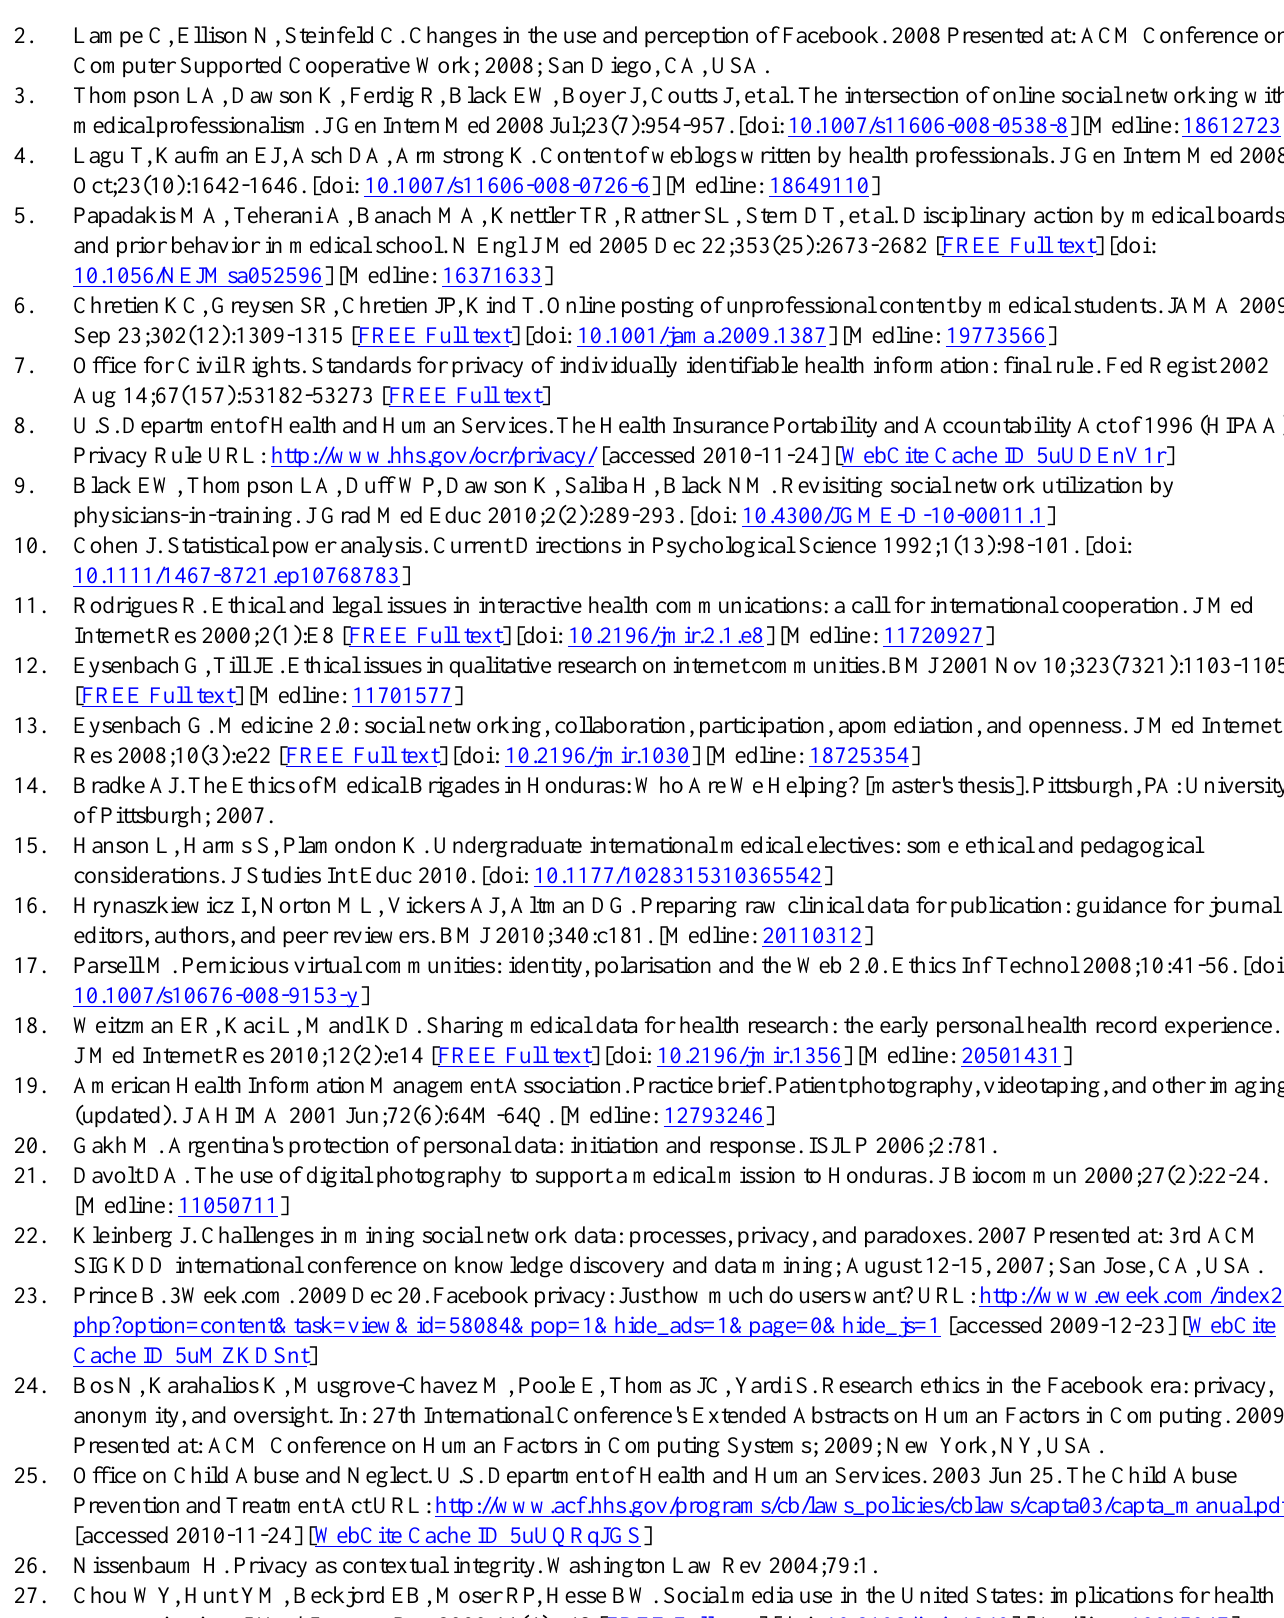
Abbreviations HIPAA: Health Information Portability and Accountability